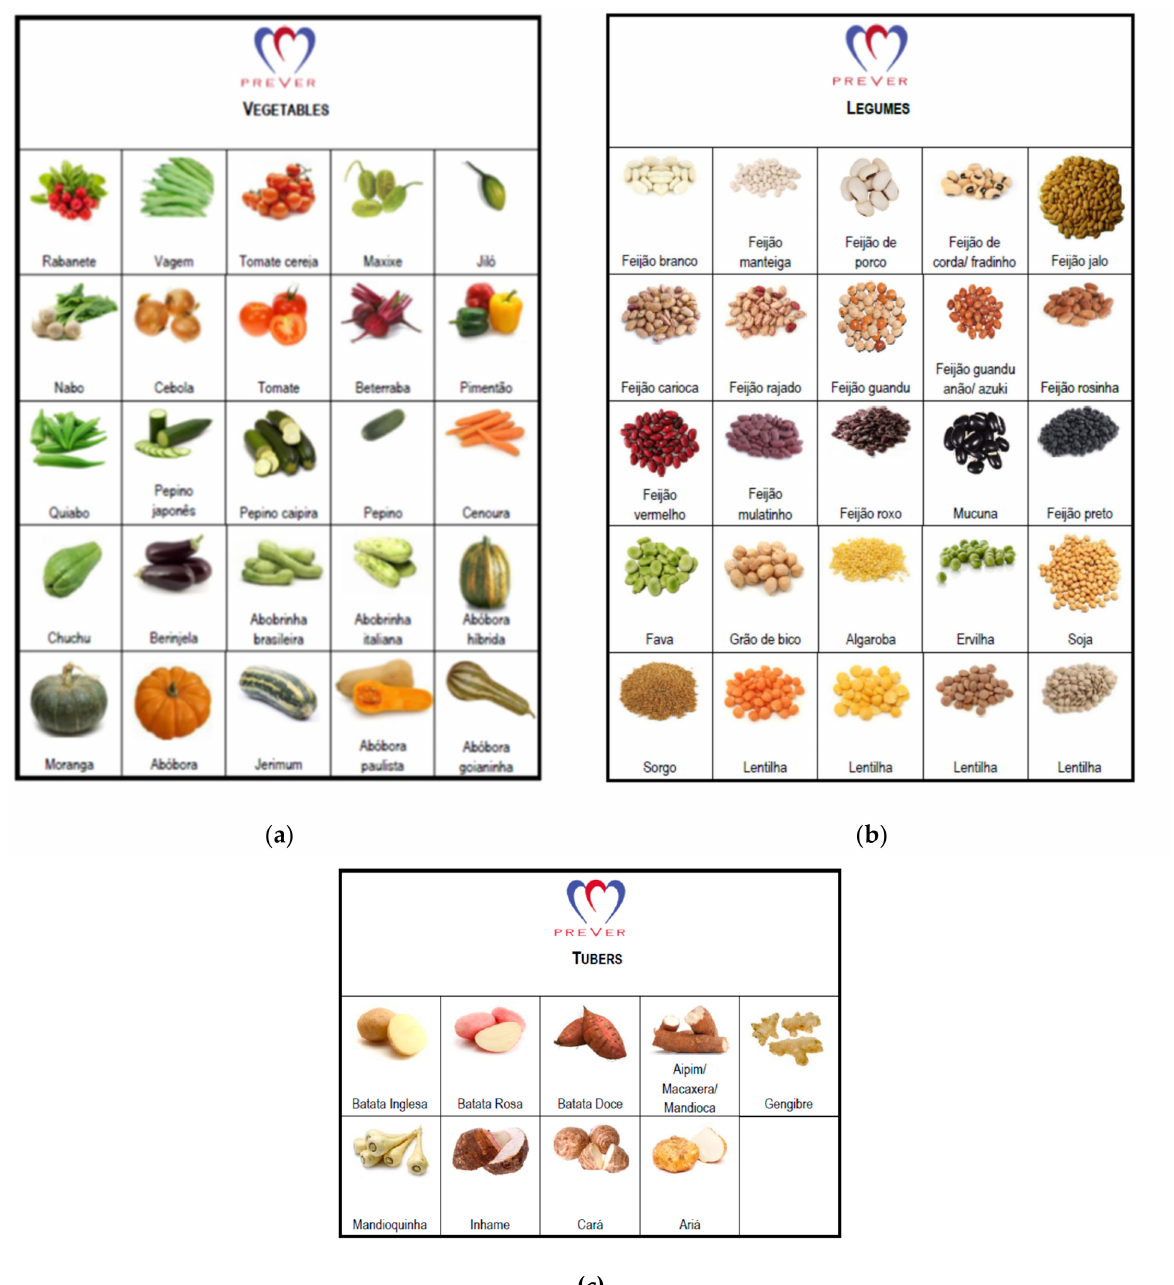
Figure 2. Vegetables, legumes, and tuber illustration cards. Schemes follow another format. Illustration used to help participants differentiating food groups used during the administration of the 30-day and 7-day FG-FFQs: ( a ) vegetables; ( b ) legumes; ( c )